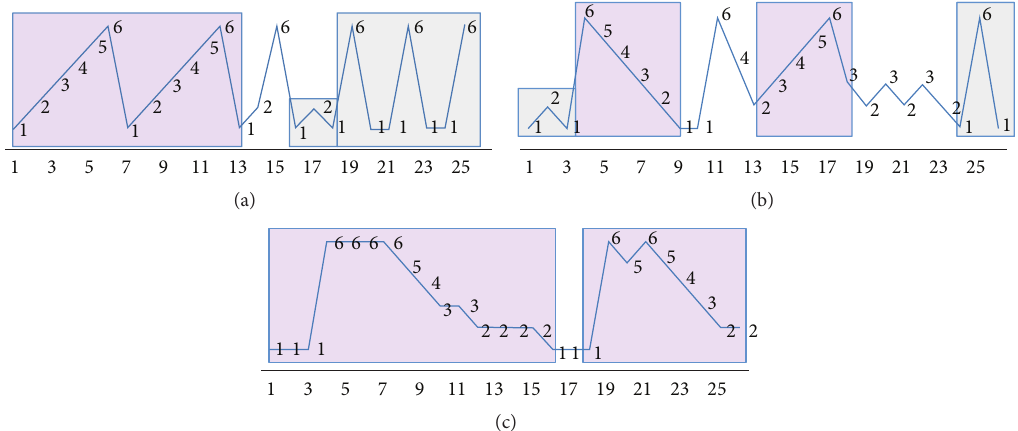
Figure 12: Some exploratory paths recorded during the second phase of the test of the Harmonic Walk . The gray areas correspond to the recursive movements, 1-6-1 or 1-2-1, while the violet areas correspond to the circular